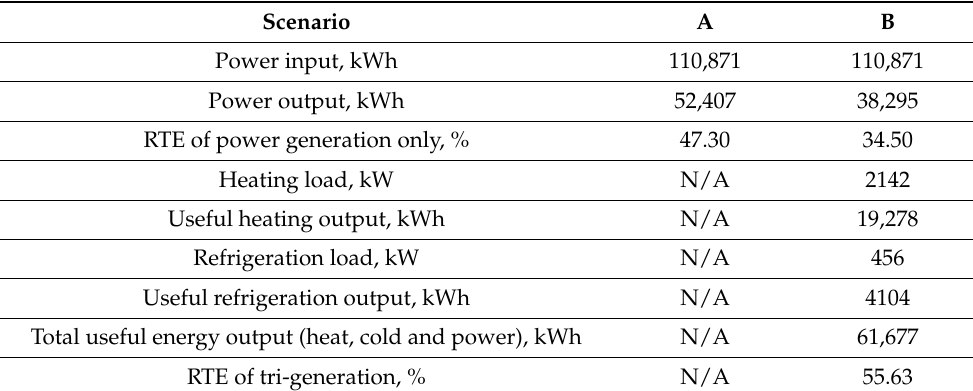
Table 3. Round-trip efficiencies of the LAES plant for scenarios A and